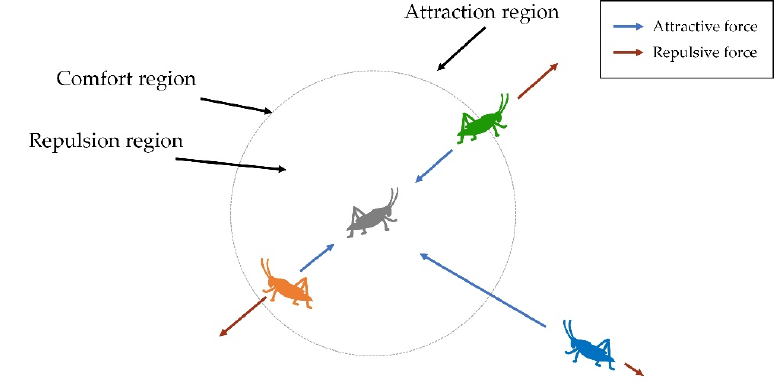
Figure 1. Schematic of the interaction between individual grasshoppers. When the distance between the two operators is relatively close (less than 2.079 units), they repulse each other, and the operator is in the repulsion region or the repulsion distance. When the distance between the two operators is exactly 2.079 units, there is neither an attractive nor repulsive force, which is called the comfort region or the comfortable distance. In the same way, when the distance between two operators is more than 2.079 units, they attract each other, which is called the attraction region or the distance of attrac ‐ tion. According to this principle, grasshopper operators will constantly adjust their posi ‐ tions with other operators to achieve optimized results.